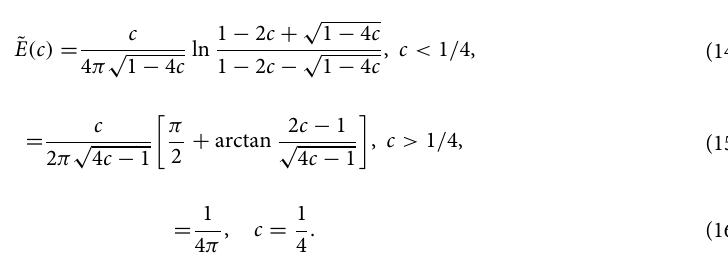
Figure 1. The rescaled average energy coupling c . The first two leading contributions